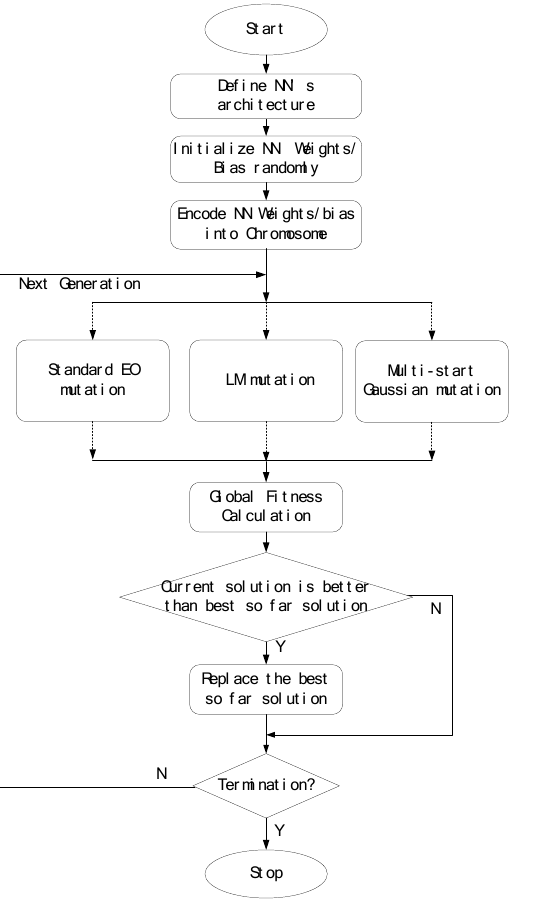
Fig. 2. Flowchart of the EO-LM